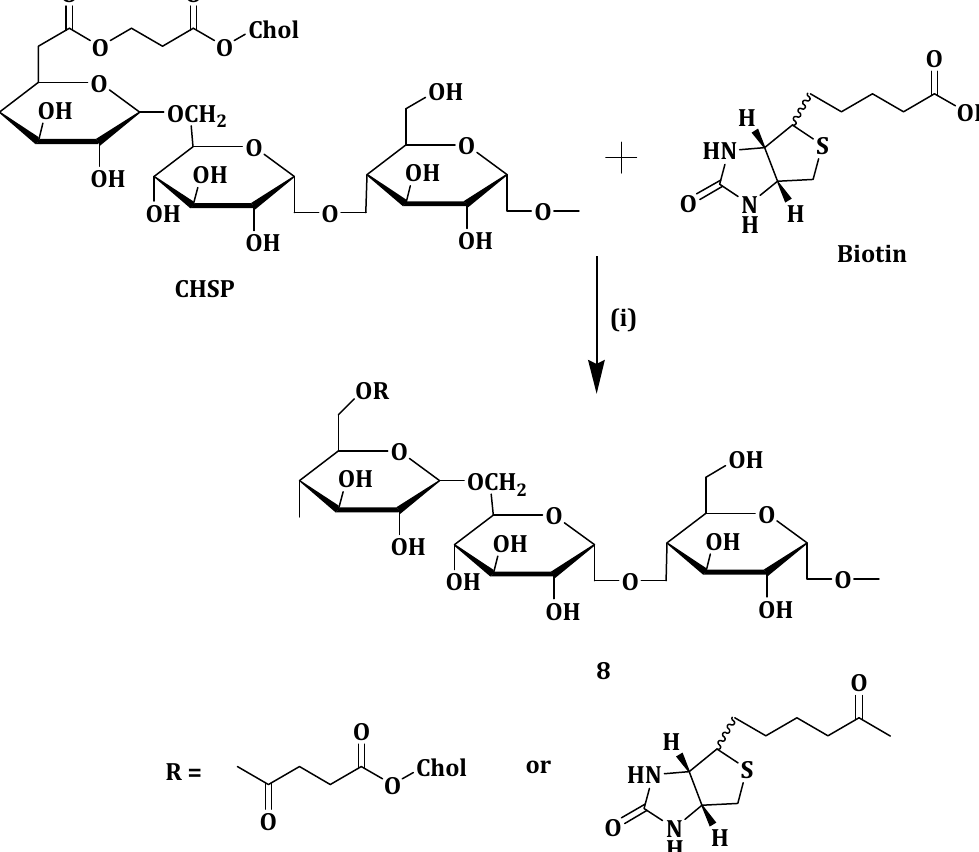
Scheme 5. Synthesis of Biotin grafted- Cholesterol-modified pullulan co-polymer ( 8 ). Reagents and conditions: (i) EDC, DMAP, DMSO, 45 °C, 5d.